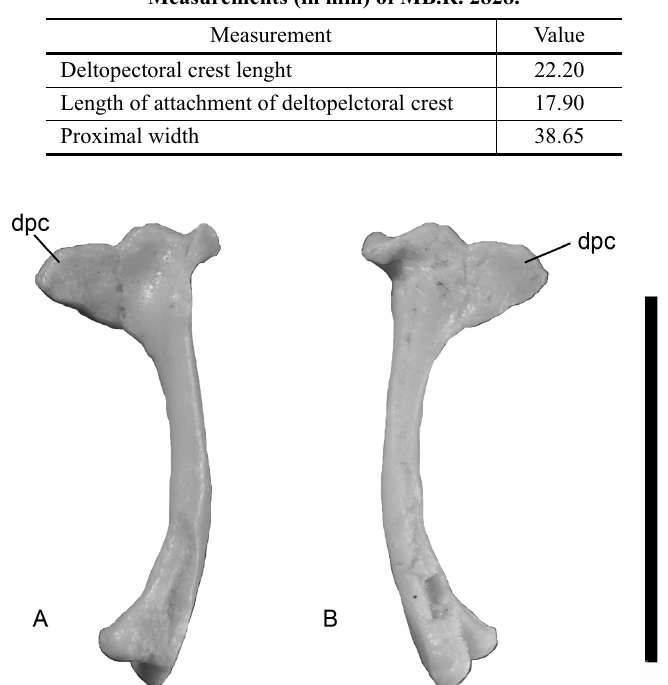
Fig. 3 – MB.R. 2833 in: A. medial view, B. lateral view; dpc – deltopectoral crest (scale 2